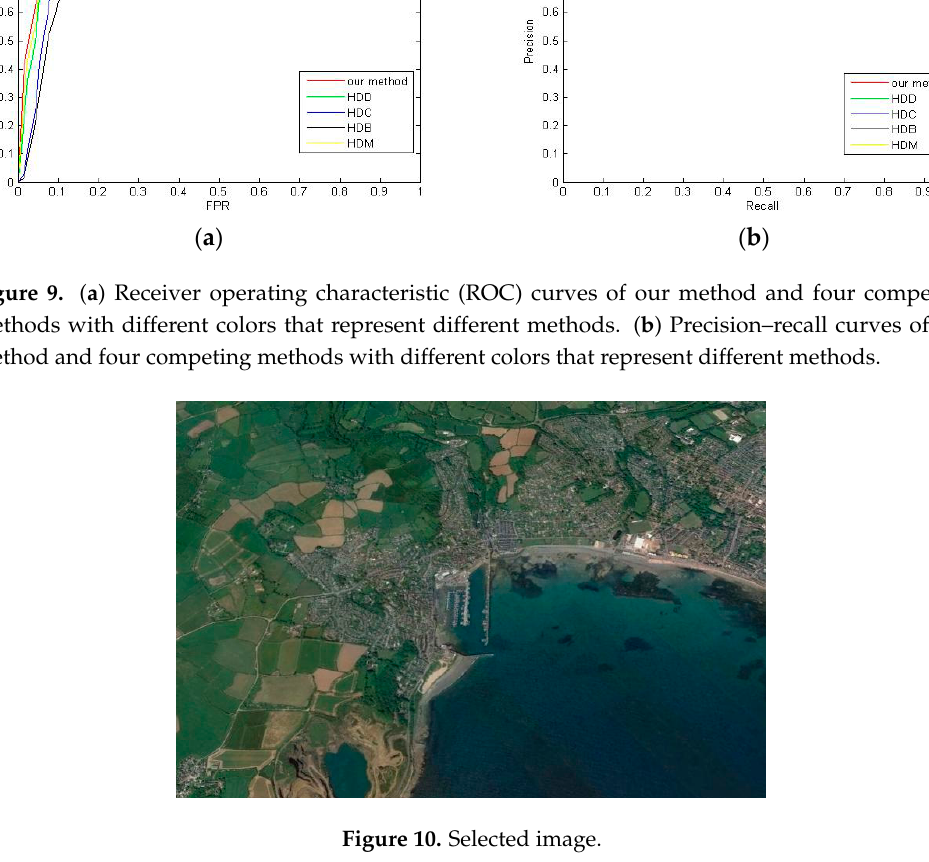
Table 6. The values of standard deviation, entropy, available edge pixels and edge pixels corresponding to the values of different parameter SCOPE.